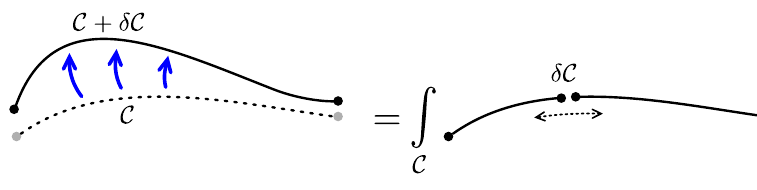
Figure 1 . The evolution equation (2.88) relates a small smooth deformation of a conformal mesonic line operator to an integrated product of two mesonic line operators.